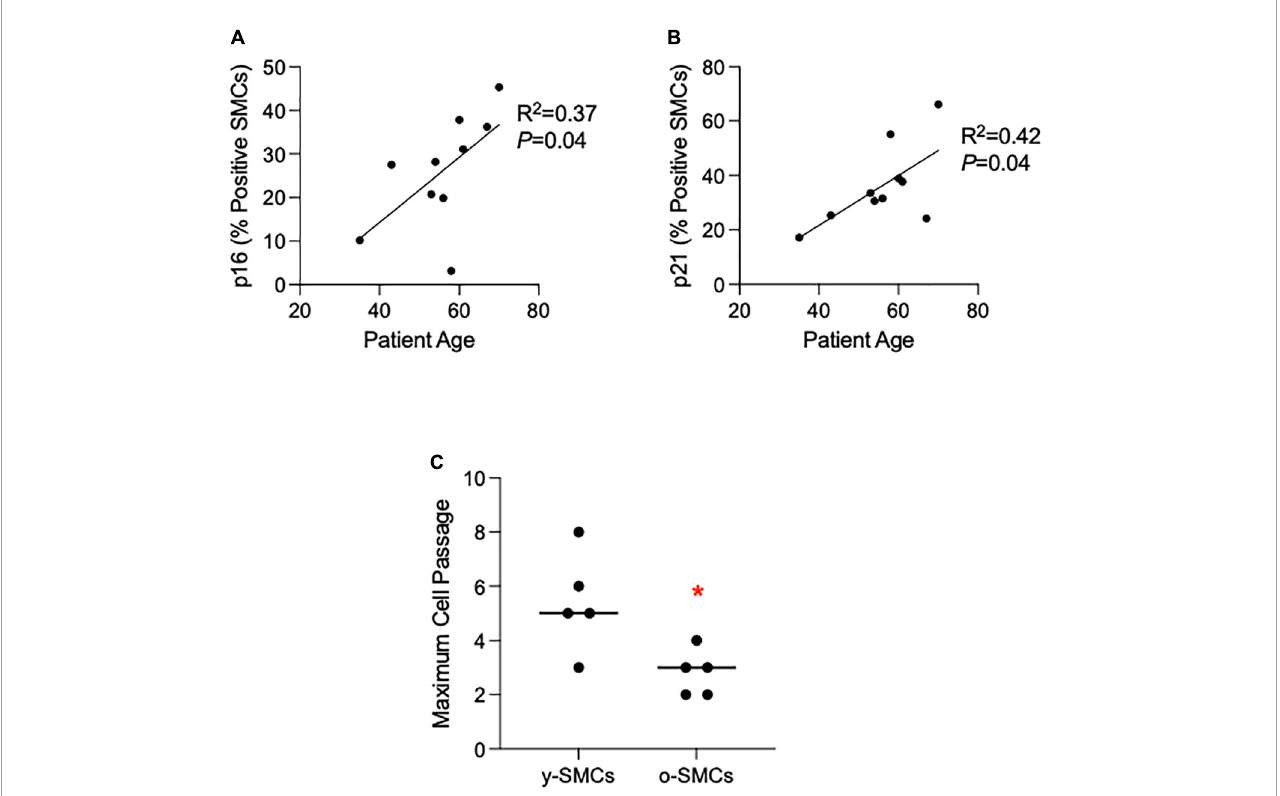
FIGURE3 Cellular senescence increases with age in smooth muscle cells (SMCs) isolated from non-dilated ascending aortas. (A,B) Graphs depicting the linear relationship between patient age and the percentage of p16- (A) or p21- (B) positive SMCs in culture. (C) Graph depicting the maximum cell passage for SMCs from either young (y-SMCs; < 55 years old) or older (o-SMCs; ≤ 55 years old) patient aortas. Comparison was made via Mann Whitney U Test. * P = 0.03. Horizontal line represents median